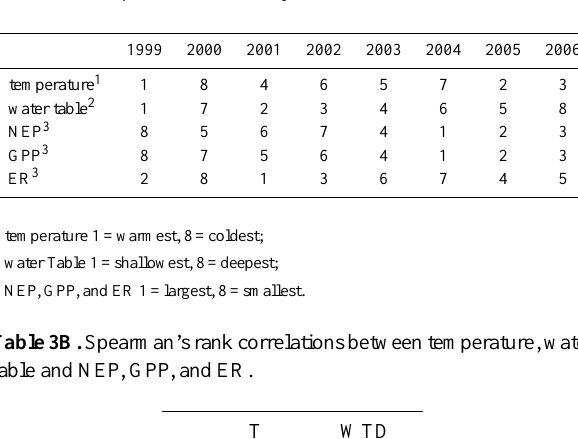
Table 3A. The ranking of the relative patterns on water table and temperatures for the 8 years of comparison between the observed and simulated peatland carbon dynamics.